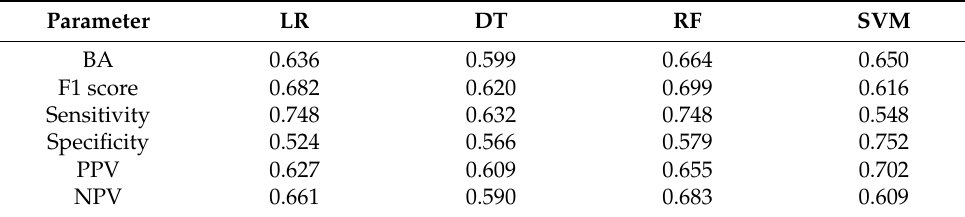
Figure 1. Confusion matrix of each machine-learning model in the test set. LR, logistic regression; DT, decision tree; RF, random forest; SVM, support vector machine. Table 3. Model evaluation parameters according to the machine-learning algorithm.